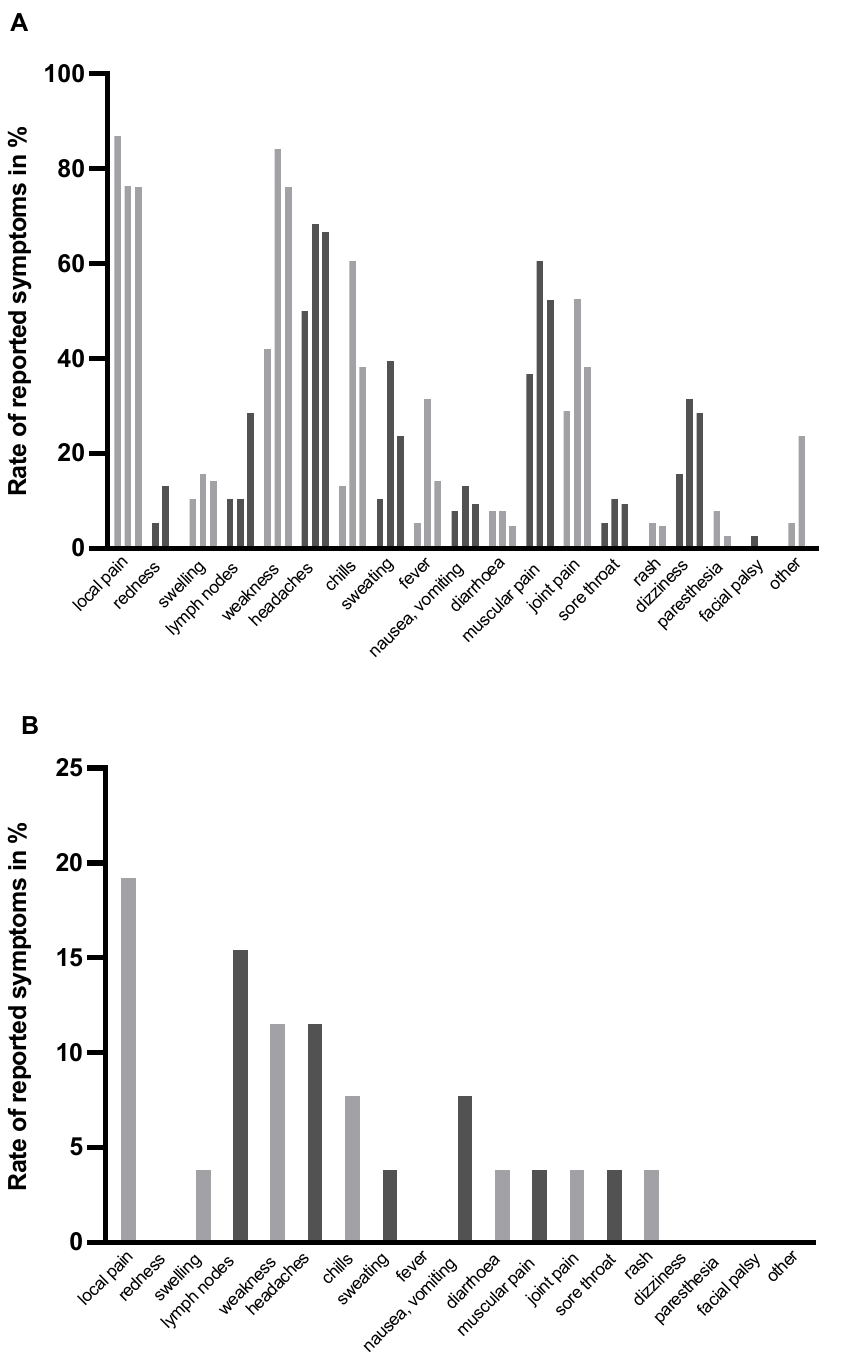
Figure 3. Rate of adverse reactions after BNT162b2 basic and booster vaccination. Panel ( A ) presents symptoms in vaccinees with most severe adverse reactions after basic vaccination (first and second bar, n = 38, respectively) and booster vaccination (third bar, n = 21); the single bar in Panel ( B ) presents symptoms in vaccinees after booster vaccination (n = 26) who had no or only minor injection site symptoms after first and second vaccination. Grey and black bars were chosen to differentiate the single symptoms and to make the figure more clearly arranged.